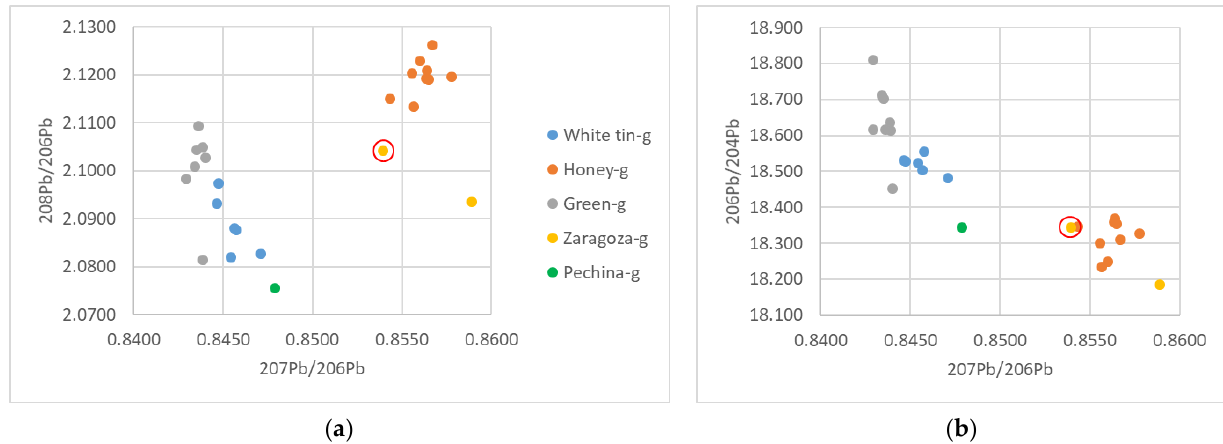
Figure 7. Lead-isotope ratios of glazes from different ceramics (white tin-opacified glazes, honey glazes, and green glazes from Albarracin; glazes from Zaragoza workshops (white tin-opacified glaze is marked with a red circle); and glaze in a sample from Pechina): ( a ) 208 Pb/ 206 Pb ratio vs. 207 Pb/ 206 Pb ratio; ( b ) 206 Pb/ 204 Pb ratio vs. 207 Pb/ 206 Pb ratio.